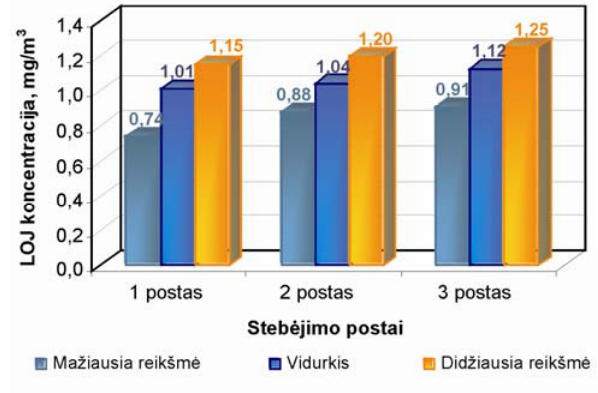
Fig 4. Histogram of VOC quantity at observation stations 4 pav . parodytos trij ų post ų vidutin ė s, mažiausios